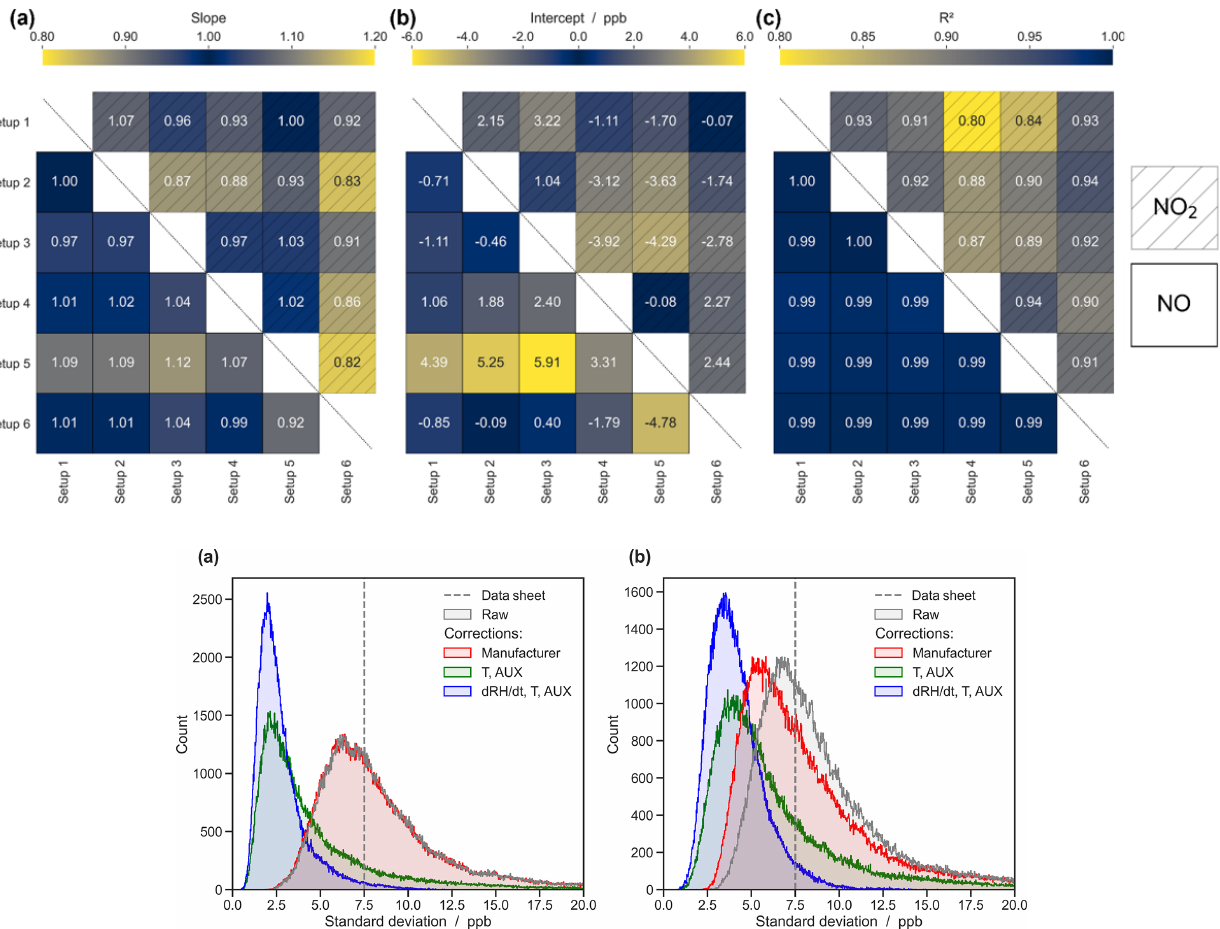
Table 2. From left to right are the (a) slopes, (b) intercepts, and (c) R 2 of the linear regressions between one setup and any other setup for ≈ 286h of measurements ( ≈ 75h in flight). The lower triangles, depicted with black framed rectangles, are the NO sensors results. The gray diagonally striped rectangles in the upper triangle show the results of the NO 2 sensors. The light-to-dark color map indicates the range from worst to best values, respectively.